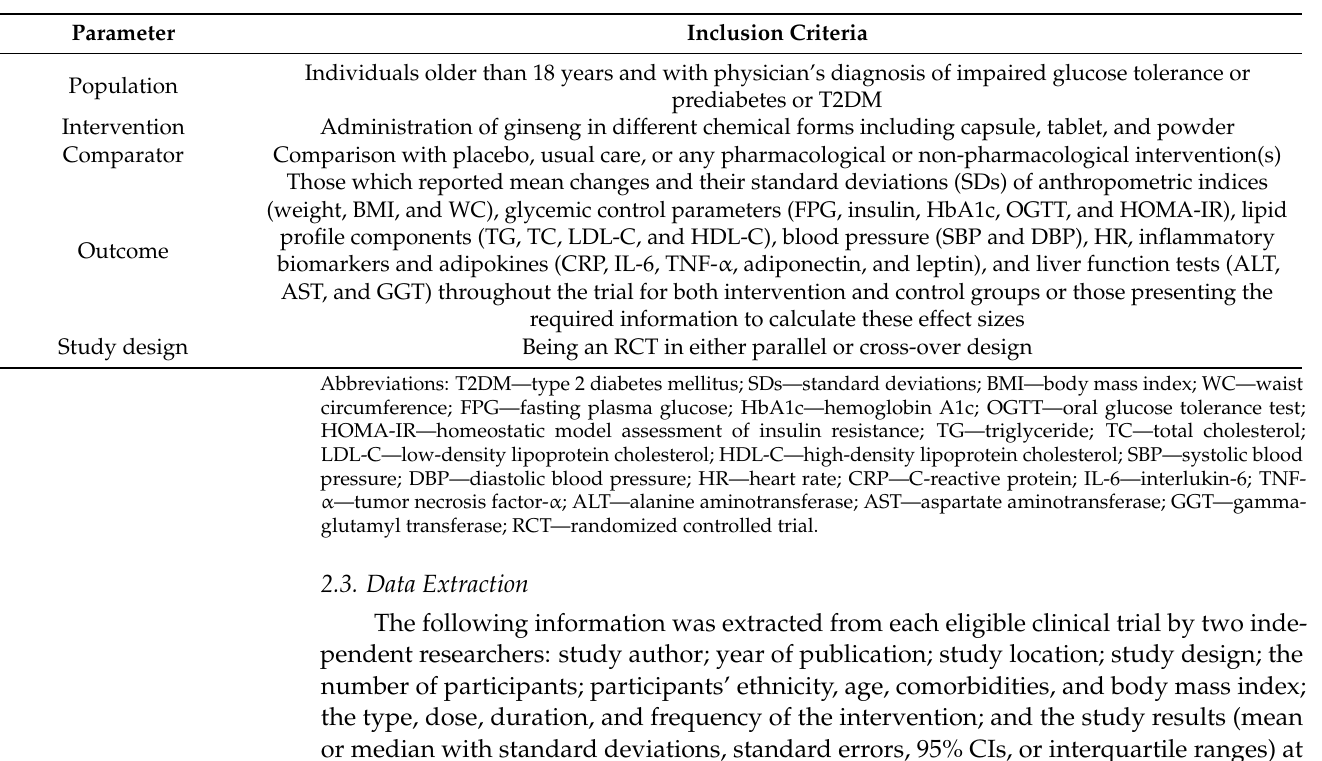
Table 1. PICOS criteria for inclusion of